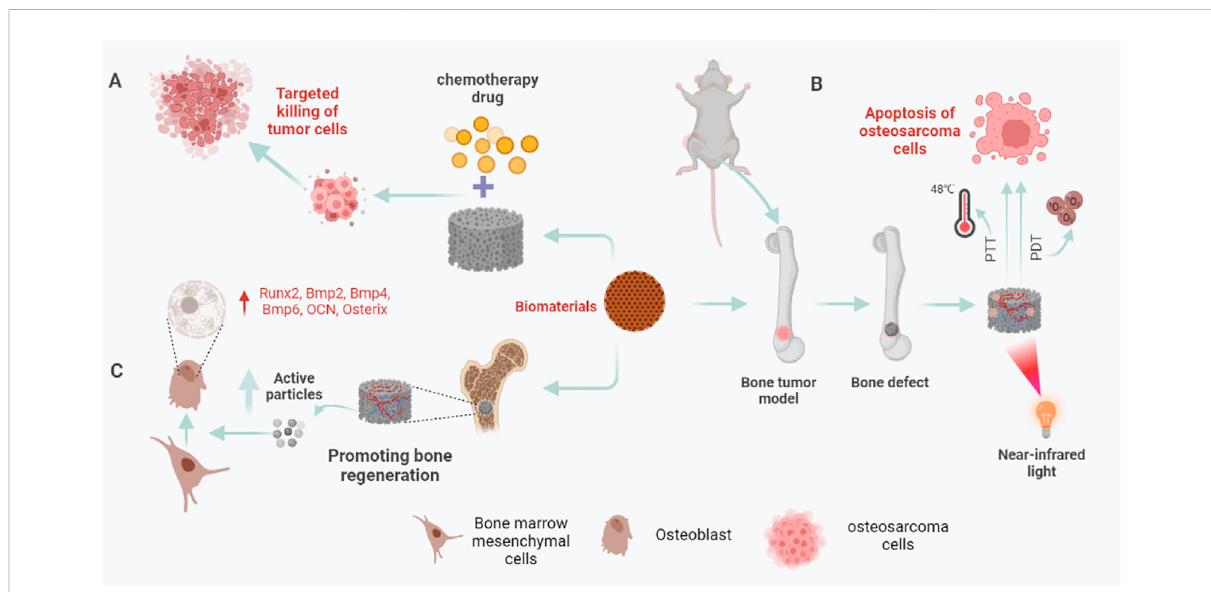
FIGURE 1 Biomaterials in bone reconstruction after osteosarcoma surgery. (A) Under near-infrared (NIR) light, biomaterials eliminate residual osteosarcoma cells through PTT and PDT to prevent a recurrence. (B) Biomaterials can be used as drug-loaded systems to target residual osteosarcoma cells, release chemotherapeutic drugs, and kill osteosarcoma cells. (C) After osteosarcoma resection, the 3D printed biomaterial scaffold can not only play therole ofbone support and bone connection but also release some active particles, such as Ag + , Cu + , PO 4 3- , etc., to up-regulate the expression of osteogenesis-speci fi c genes and promote bone